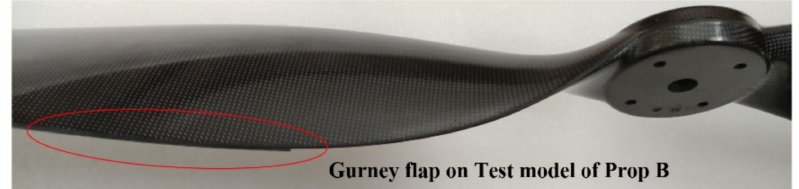
Figure 25. The detail of the Gurney flap on the test